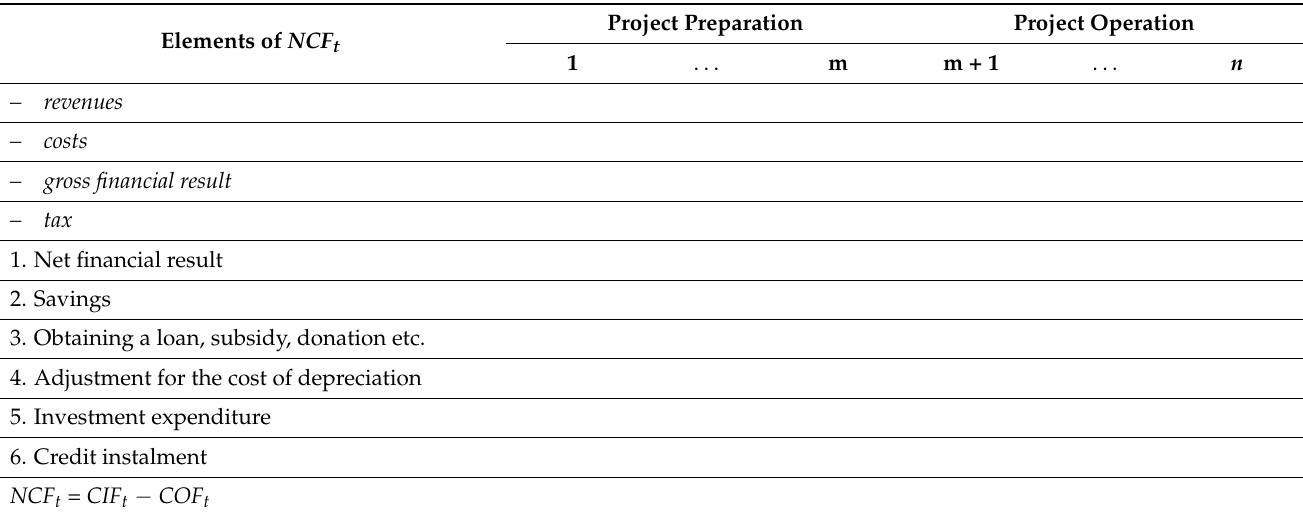
Table 5. List of NCF t identifying the project within the calculation period. Source: designed by